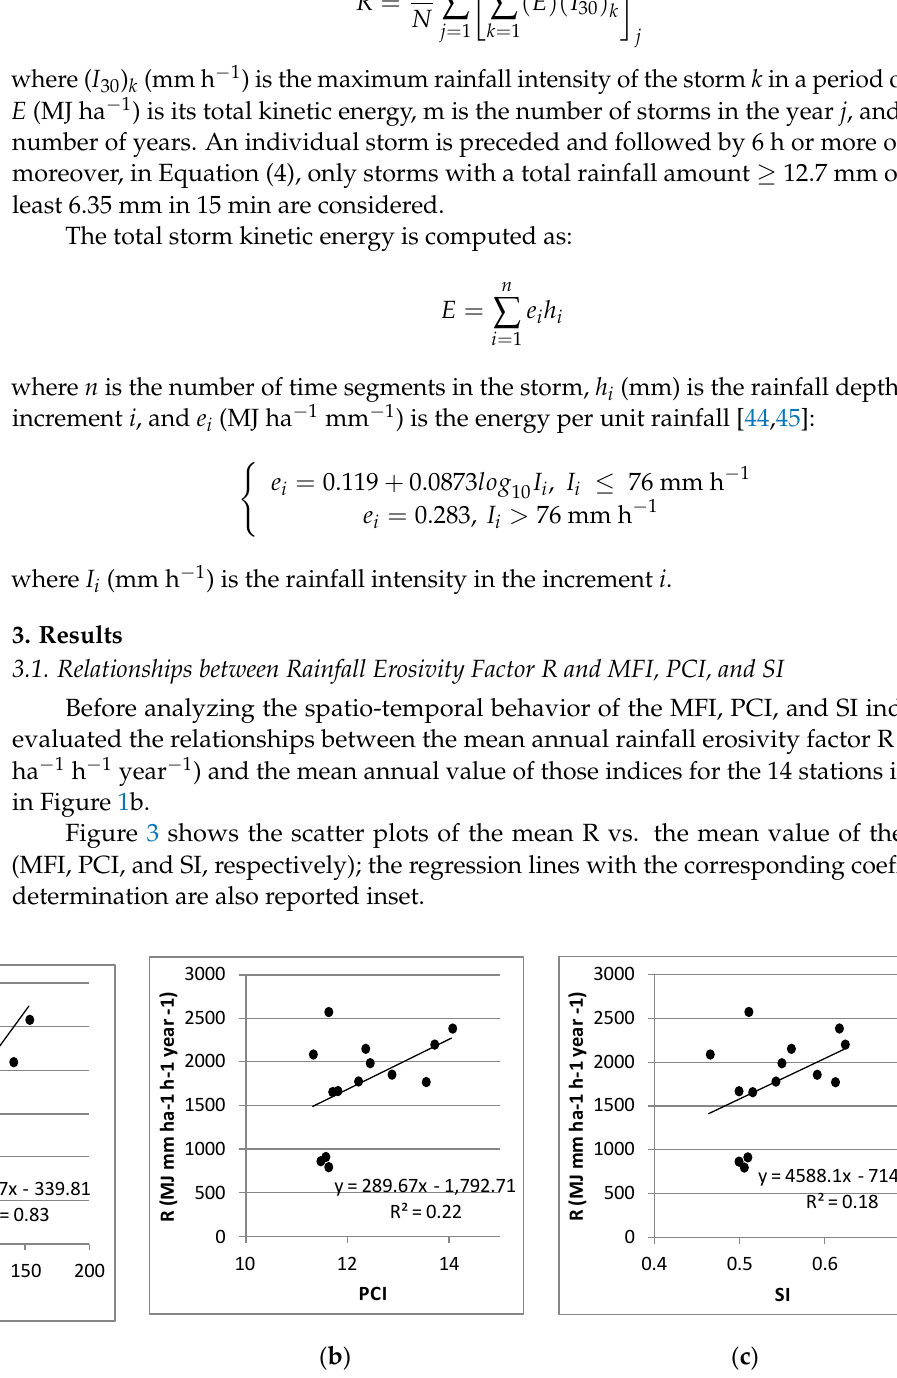
Figure 3. Scatter plots and linear regression lines of mean annual erosivity R vs. mean annual MFI ( a ), PCI ( b ), and SI ( c ) at 14 stations.